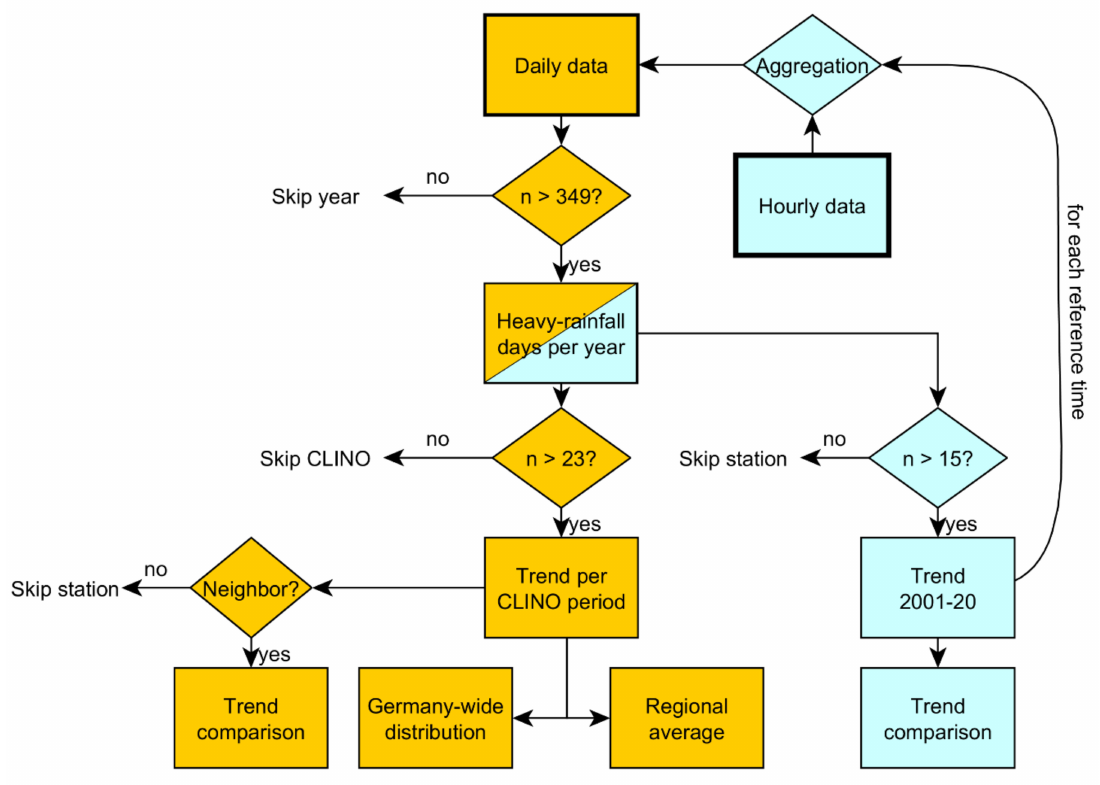
Figure A1. Flow chart of data